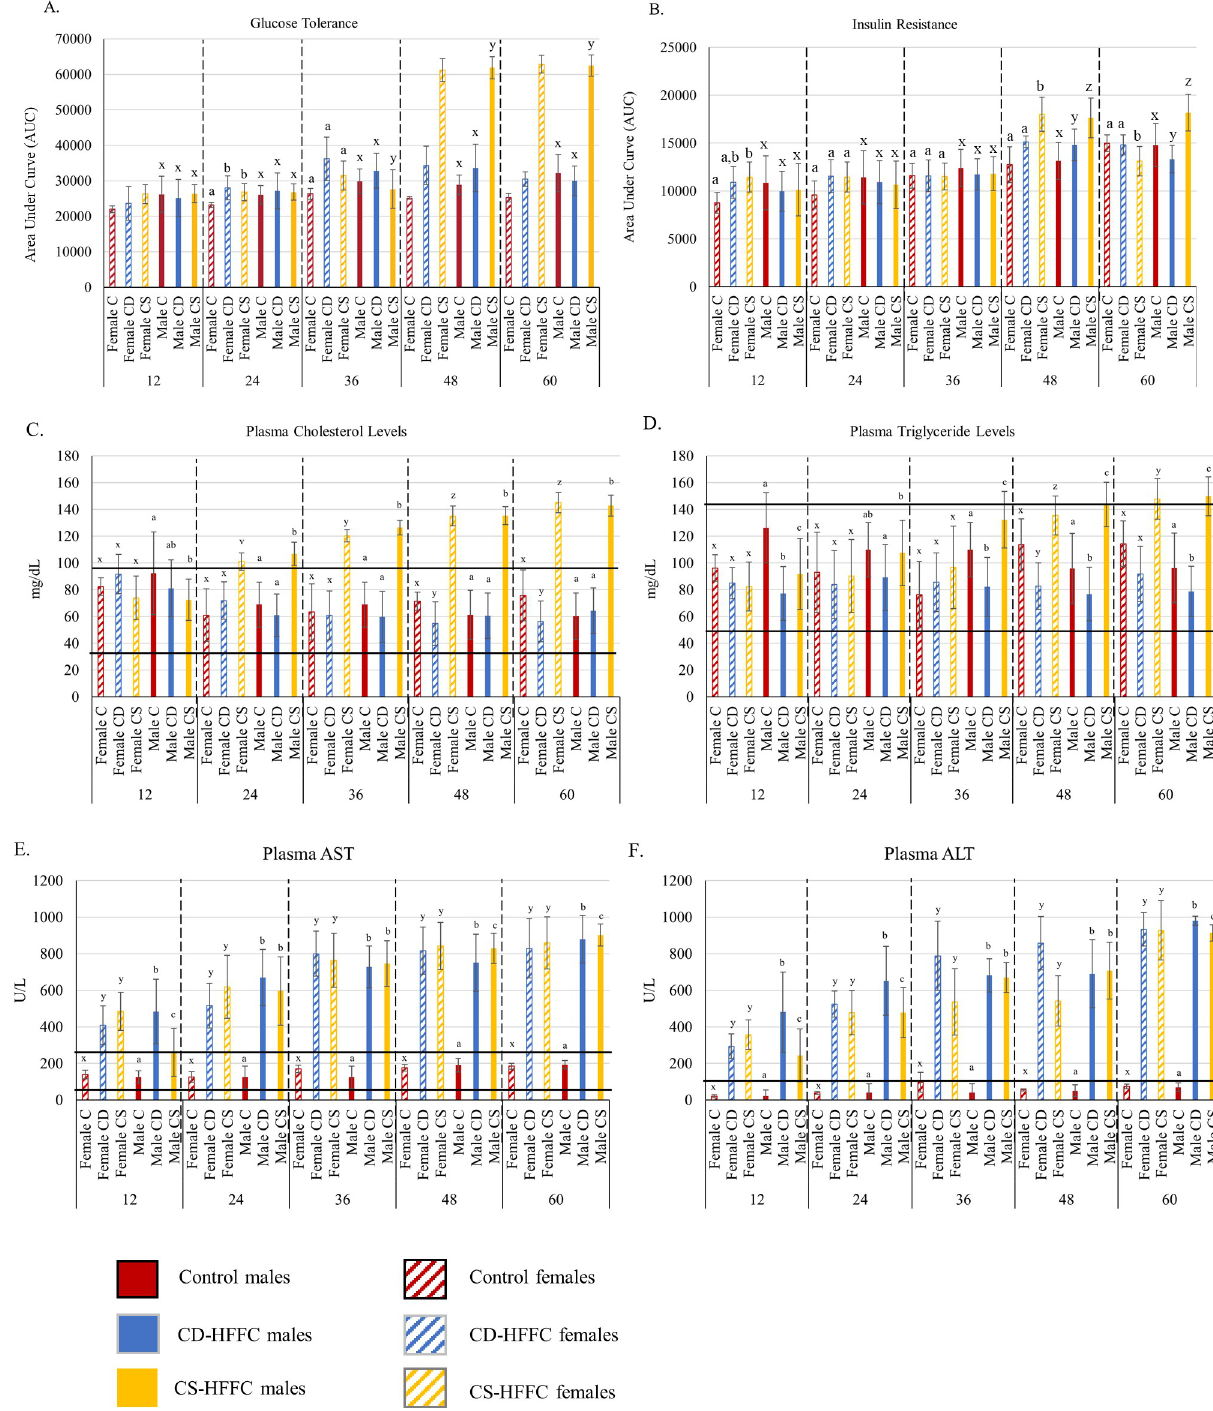
Fig 3. Metabolic function, plasma lipids, and plasma enzymes in mice fed with the control (C), CD-HFFC (CD), and CS-HFFC (CS) diets. (A) Glucose tolerance. Both male and female mice fed with the CS-HFFC diet exhibited intolerance to glucose at 48 (p = 1.11 x 10–16, 1.02 x 10–13) and 60 (p = 1.11 x 10–16, 1.11 x 10–16) weeks of age. (B) Insulin resistance. No differences were observed until 48 weeks of age. Male and female mice fed with the CS-HFFC diet were insulin resistant at both 48 (p = 5.41 x 10–13, 5.31 x 10–6) and 60 (p = 7.59 x 10–13, 0.015) weeks of age. (C) Plasma cholesterol and (D) plasma triglyceride levels. (E) Plasma AST and (F) plasma ALT levels. Horizontal black lines indicate lower and upper limits of normal plasma lipid and enzyme levels. Statistical differences between diet groups are shown with either a,b,c or x,y,z, markings above the graphs (one set used for males and the other for females), where statistically significant differences would be denoted by different letters across diets.